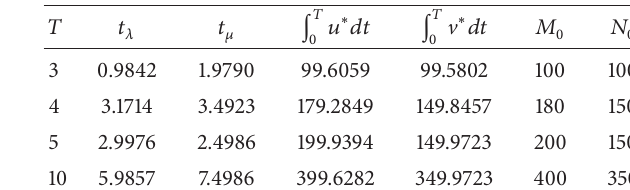
Table 1: The feasible solutions of the game problem when setting the